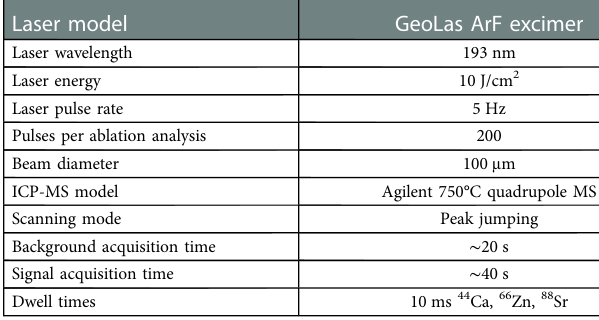
TABLE 1 Laser and ICP-MS speci fi cations and operating